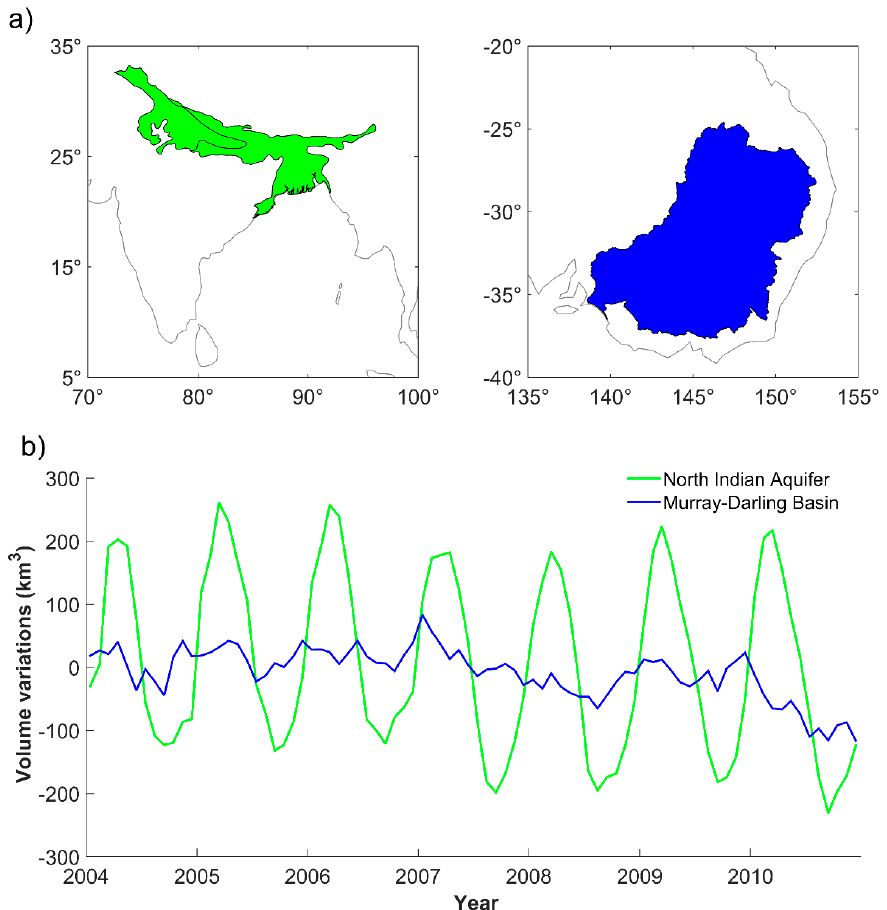
Figure 5. GW declines affect a lot of regions in the world such as the North Indian Aquifer (green) and the Murray-Darling Basin (blue) ( a ). Time variations of monthly GW storage from January 2004 to December 2010 over the North Indian Aquifer (green) and the Murray-Darling Basin exhibit the depletion of several tenths of km 3 . GWS were estimated as the difference between TWS from GRACE (GFZ RL05 solutions) and SM (and snow) from GLDAS NOAH 2.7.1 ( b ).